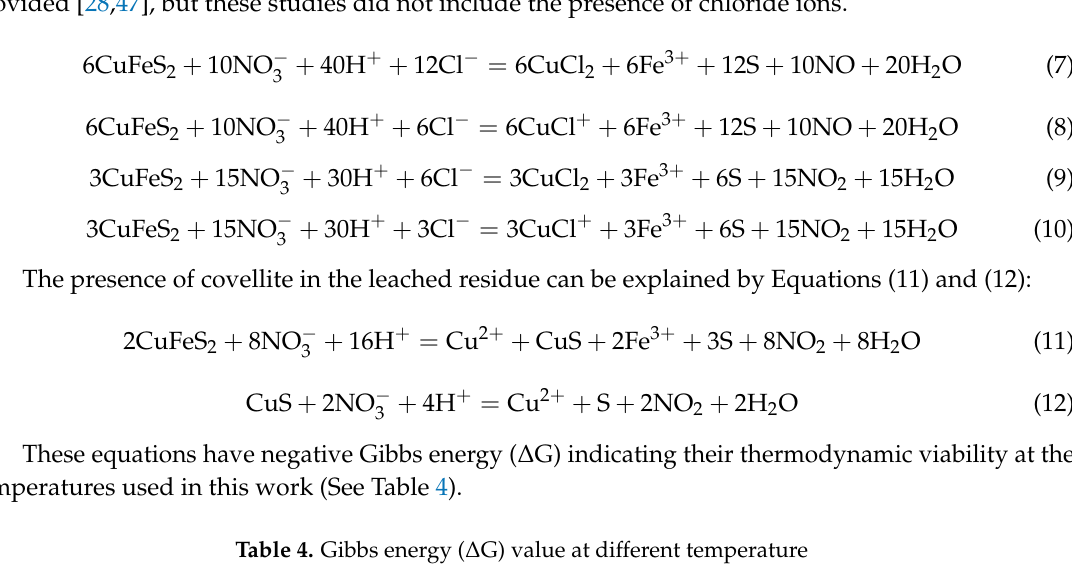
Table 4. Gibbs energy ( ∆ G) value at different